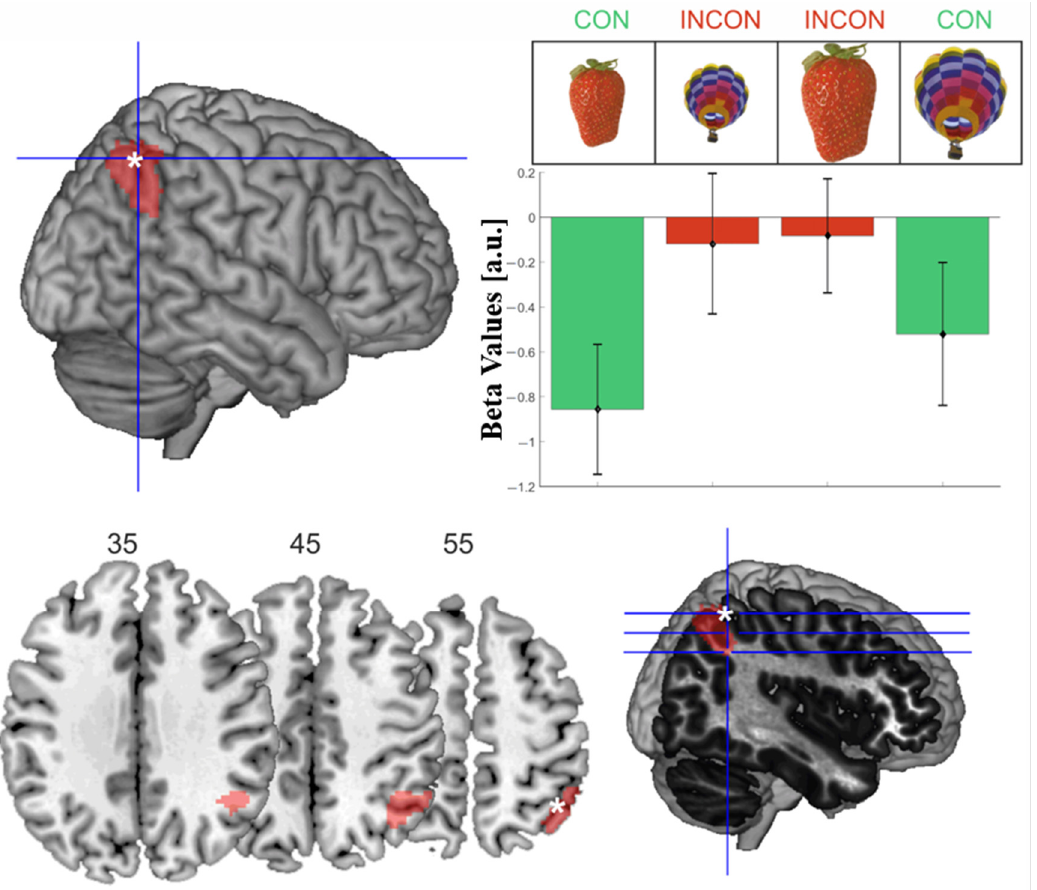
Figure 4. Visualization of the activations for the interaction contrast . More activation for incon- gruent > congruent objects was found within the right intraparietal sulcus. ( Top left ) white asterisk indicates the activation’s peak voxel (44, − 56, 56); ( top right ) beta values extracted from the peak voxel are plotted for the four conditions; ( bottom row ) three exemplary slices were visualized using MRIcron, corresponding to the blue lines on the right with the peak voxel indicated by the white asterisk.